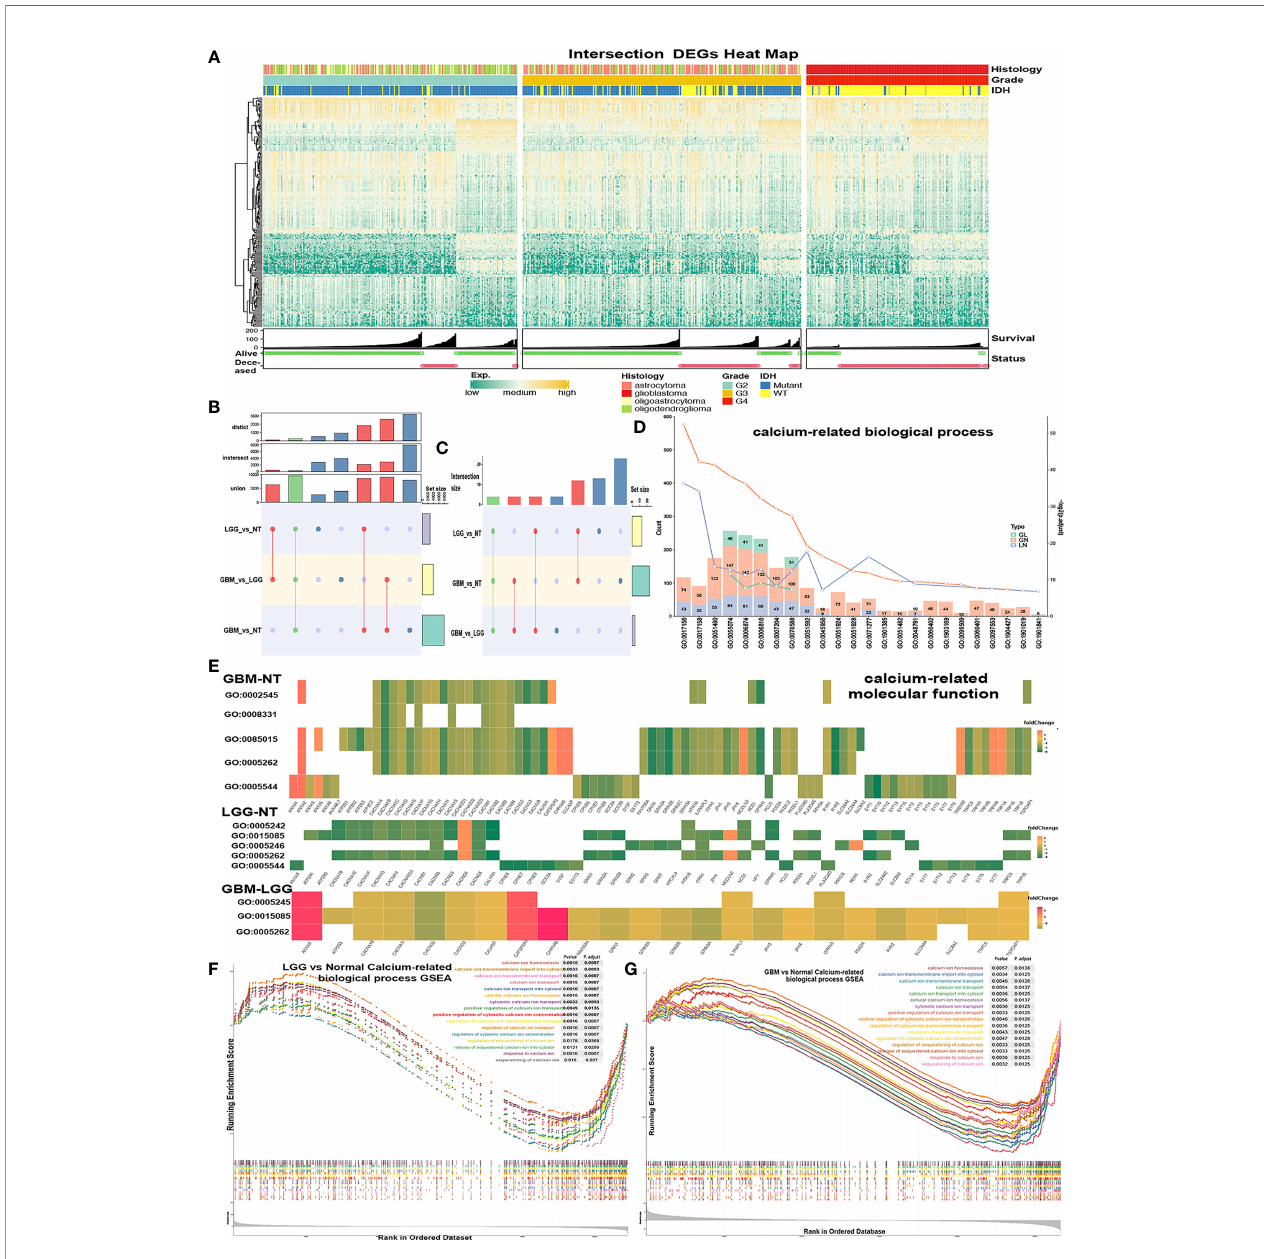
FIGURE 1 | Screening calcium-related enrichment terms for obtaining calcium genes. (A, B) Intersect DGEs (TCGA-DEGs, p < 0.05, log2(FoldChange) > 2) of GBM-NT, LGG-NT, and GBM-LGG. (C – E) Enrichment analysis of the DEGs in signi fi cantly (p < 0.05) enriched calcium-related GO biological processes terms. (C) The count of enriched terms among the GBM-NT/GBM-LGG/LGG-NT groups. (D) The gene count of each calcium-related term was marked on each color bar (green = GBM-LGG, red = GBM-NT, purple = LGG-NT). (E) Enrichment analysis heatmap of the TCGA-DEGs in signi fi cantly (p < 0.05) enriched calcium-related GO molecular function terms. (F, G) Gene-set enrichment plots show enriched calcium-related terms (p < 0.05) in the GBM-NT group (G) and LGG-NT (F)